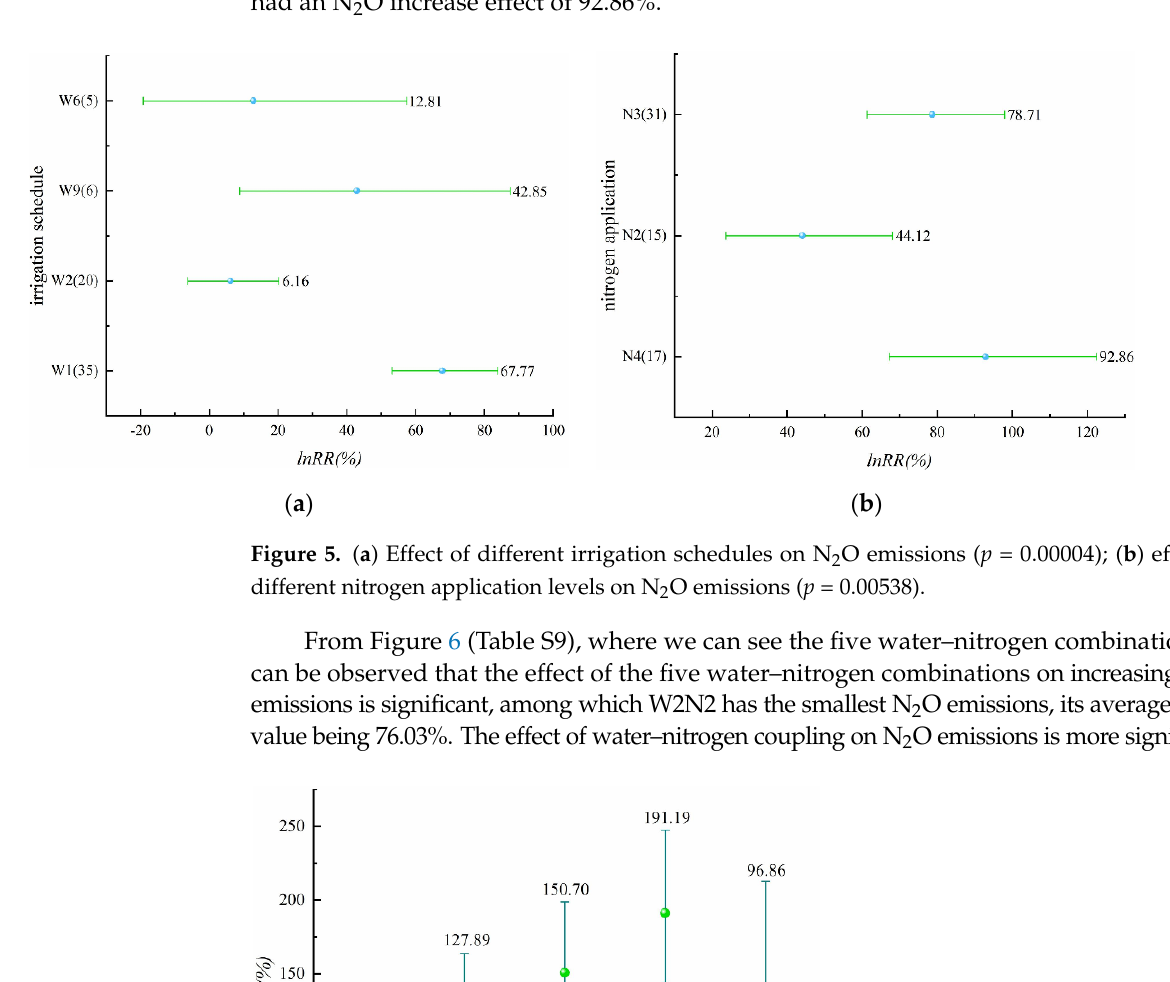
Figure 6. Effect of different water – nitrogen combinations on N 2 O emissions ( p = 0.00000).